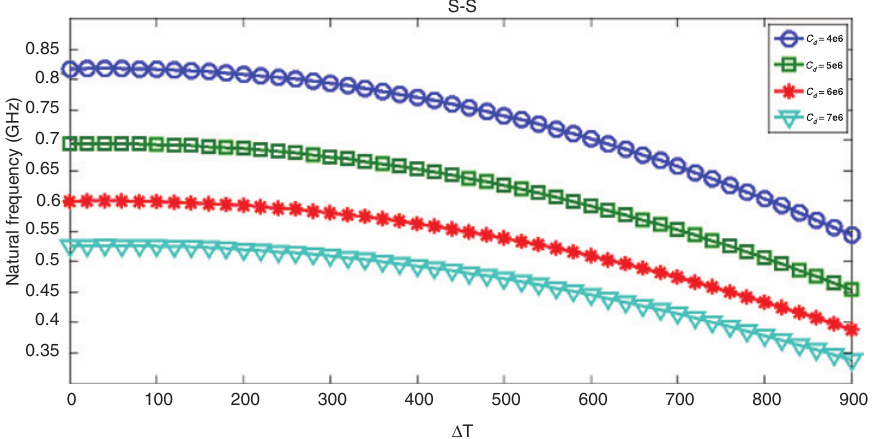
Figure 15: The effect of damping stiffness on the natural frequency with simply-simply boundary